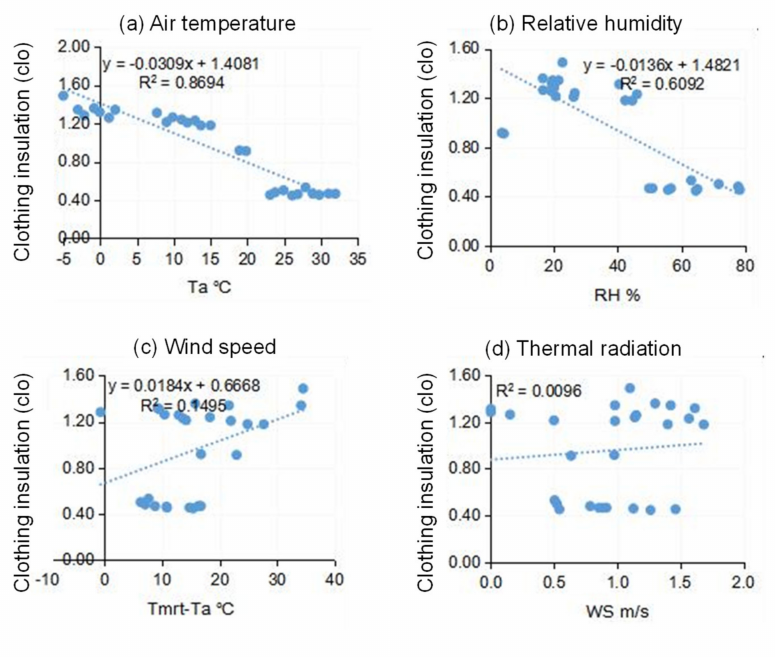
Figure 13. The clothing insulation level with respect to T a , RH , WS , and T mrt − T a for: ( a ) Air temperature, ( b ) Relative humidity, ( c ) Wind speed, and ( d ) Thermal radiation.